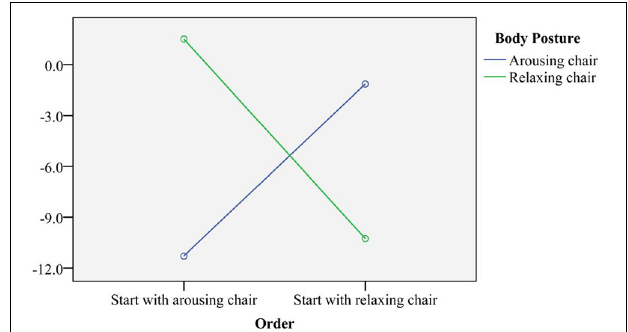
FIGURE 2 | Interaction effect between body posture and order on time production in seconds. Note that the data point arousing chair and start with relaxing chair means that the group did the experiment in the arousing chair after they did the experiment in the relaxing chair (as they started with the relaxing chair). The data point arousing chair and start with arousing chair indicates that the group started the experiment in the arousing chair and, subsequently, they did the experiment in the relaxing chair (data point: relaxing chair, start with arousing